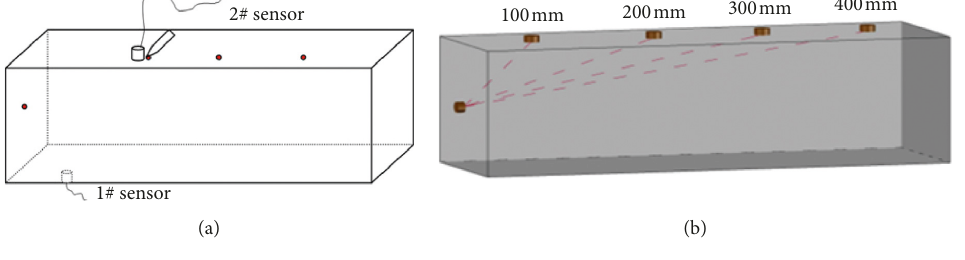
Figure 1: Pencil lead break